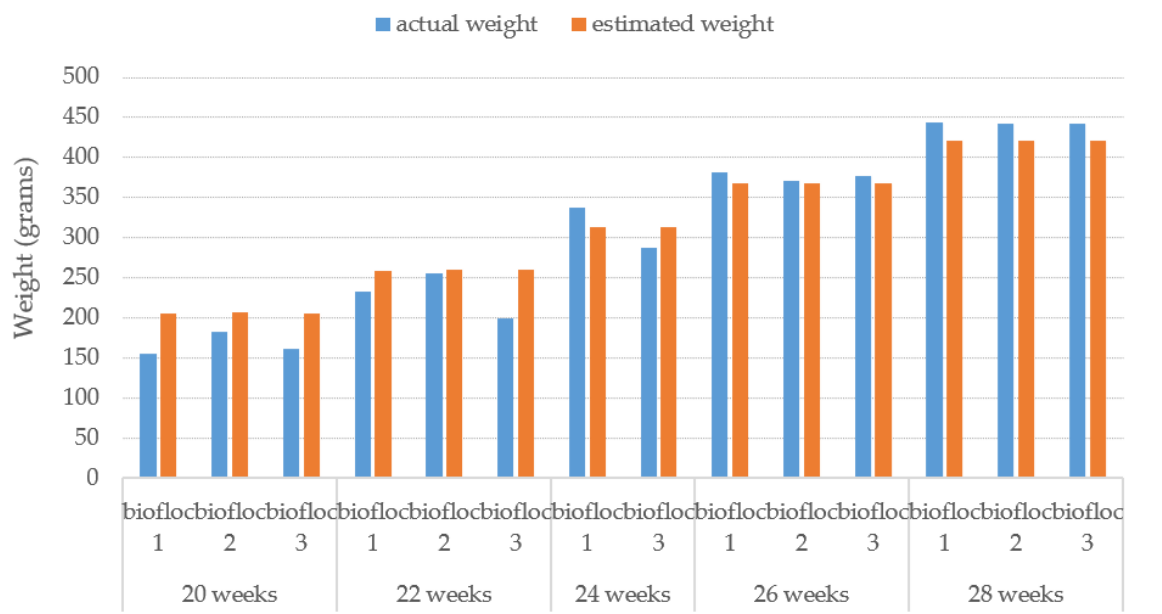
Figure 16. Tilapia Detection performance presented via box − plot estimated errors of length ( right ) and width ( left ) of Tilapia’s size.